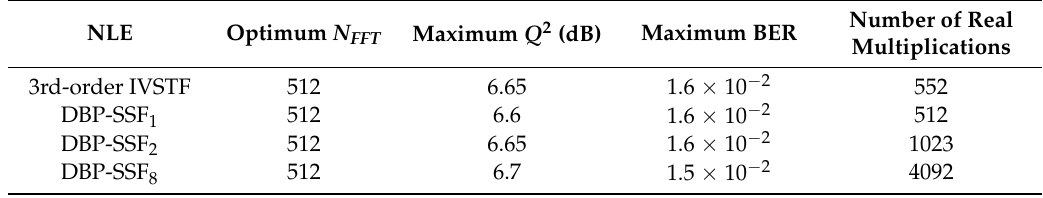
Table 2. Maximum Q 2 -factor and the corresponding number of real multiplications per sample per polarization required at the optimum N FFT , after 11 × 100 km of LEAF at optimum input power equal to − 6